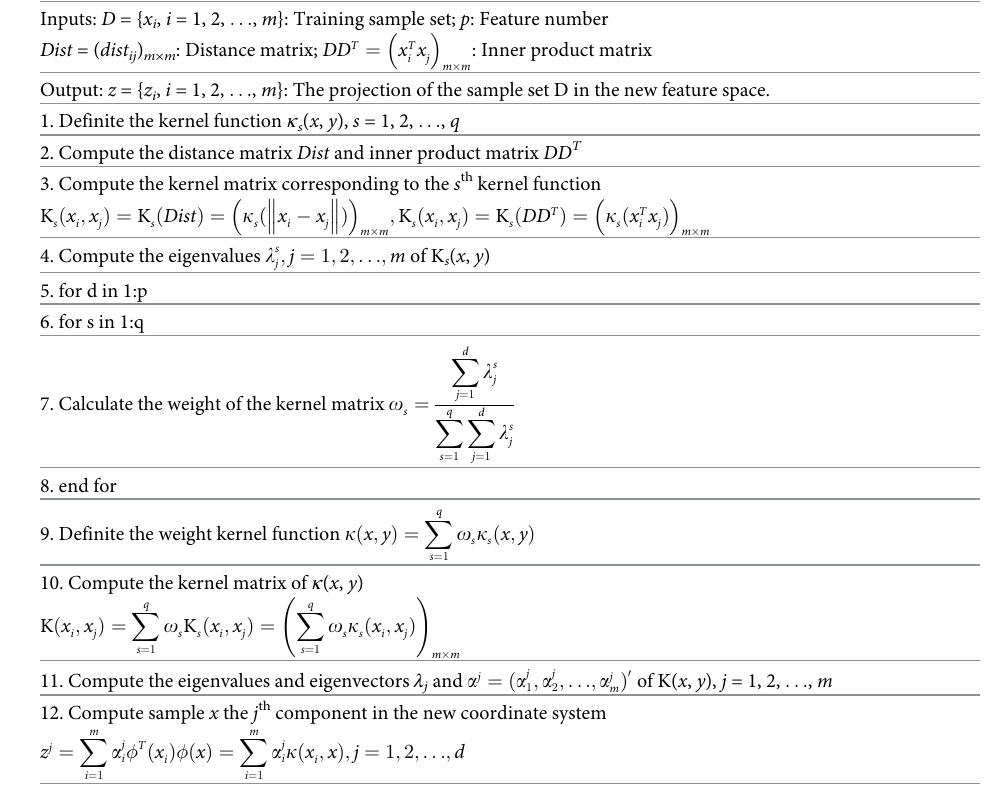
Table 1. WKPCA dimension reduction algorithm flow. Algorithm: WKPCA Dimension